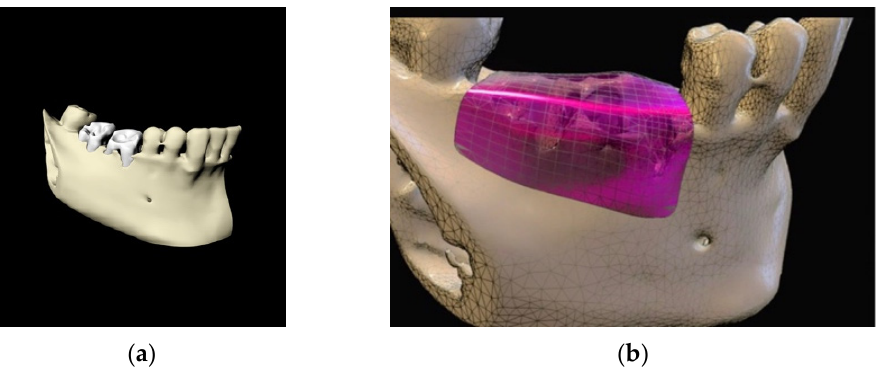
Figure 10. ( a ) 3D model of the mandible; ( b ) Titanium foil digital design.